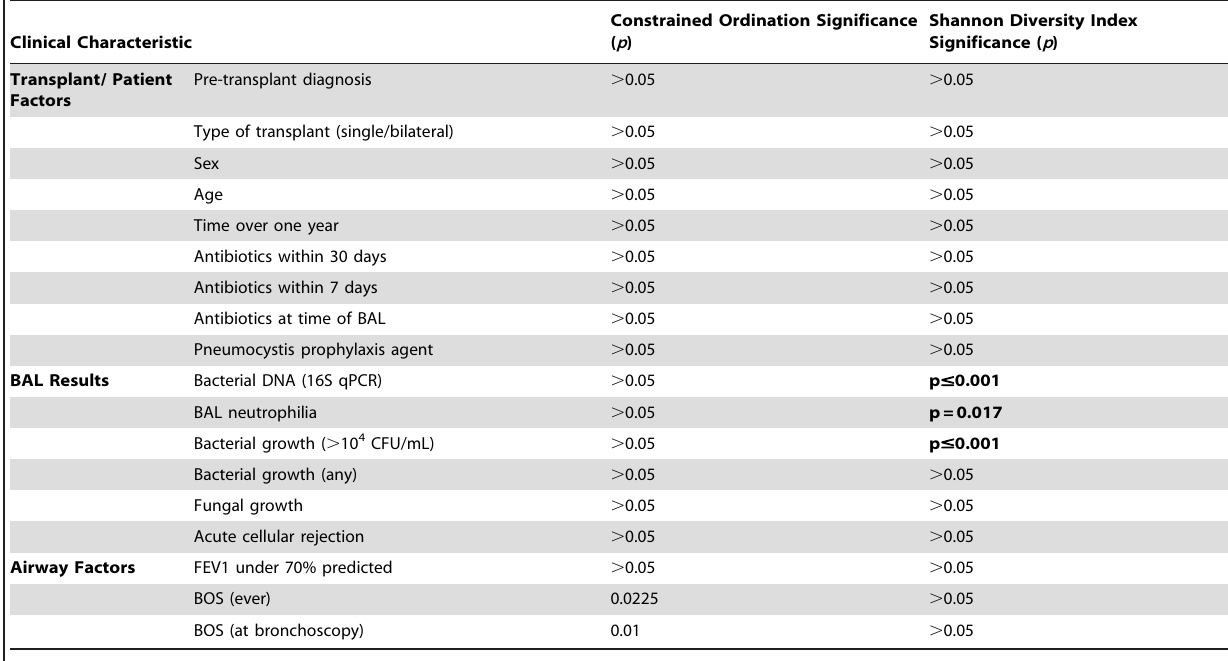
Table 4. Significance of Comparisons of Lung Transplant Recipients by Diversity Analysis and Constrained Ordination.